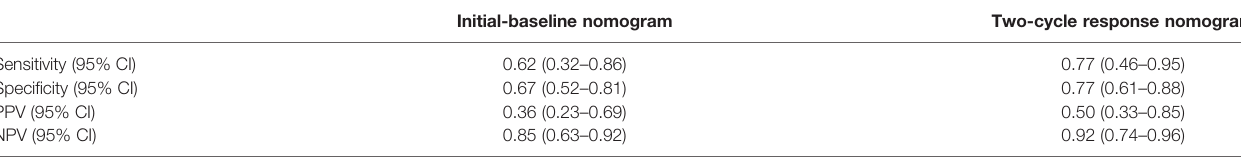
TABLE 3 | The predictability of pCR by the nomogram of initial-baseline and two-cycle response. Initial-baseline nomogram Two-cycle response